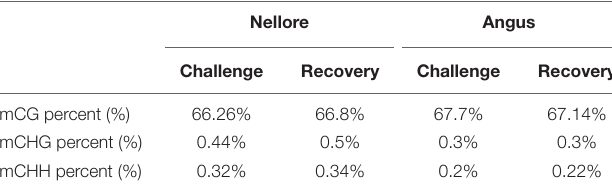
TABLE 2 | Genome-wide percentage of methylated CG, CHG, and CHH in Nellore and Angus breed during challenge and recovery